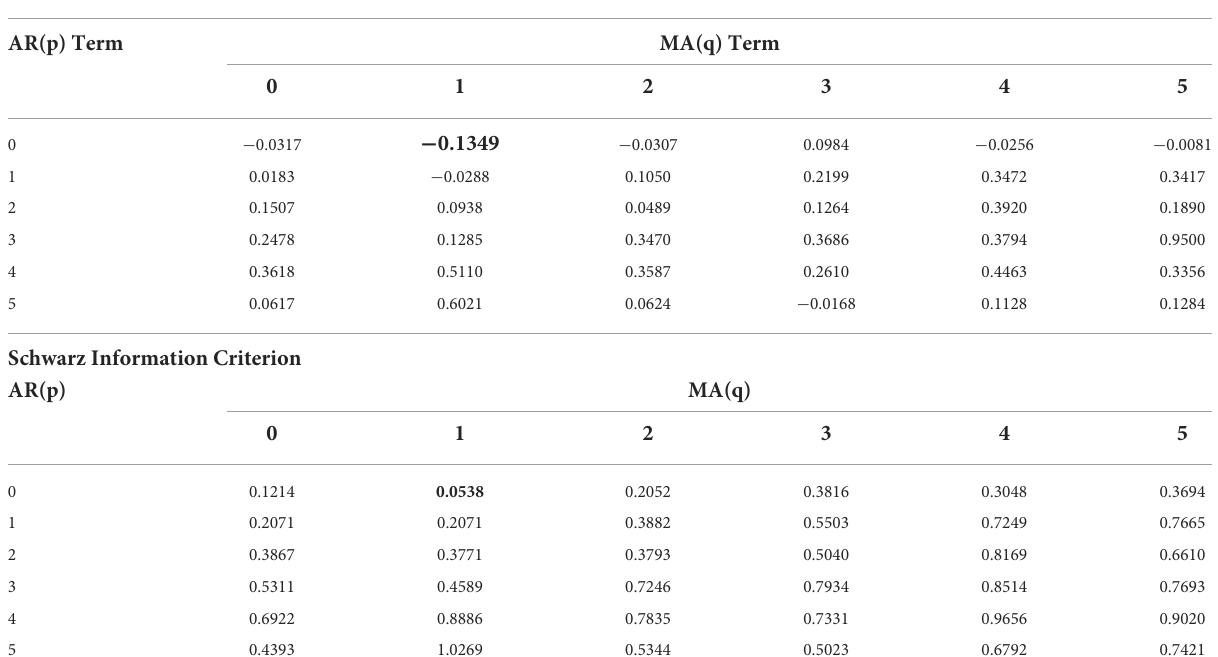
TABLE 4B Information criteria of alternative